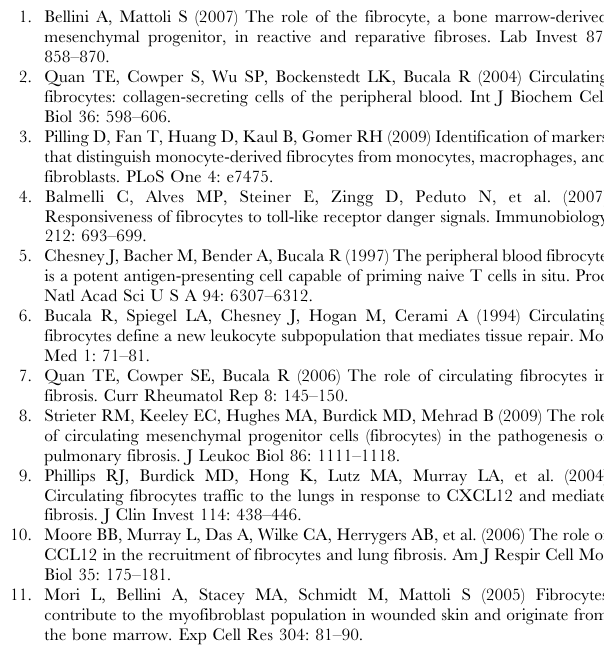
Table S2 Genes identified by SAM (0.1% FDR) when comparing monocytes, macrophages, osteoclasts, iDC, mDC, SC fibrocytes and SF fibrocytes.